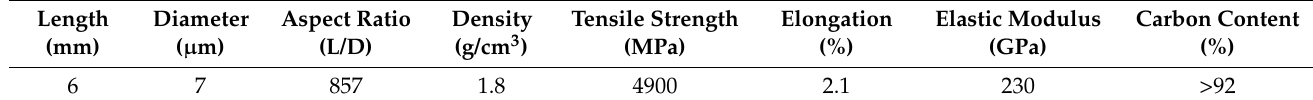
Table 2. Physical properties of CF.